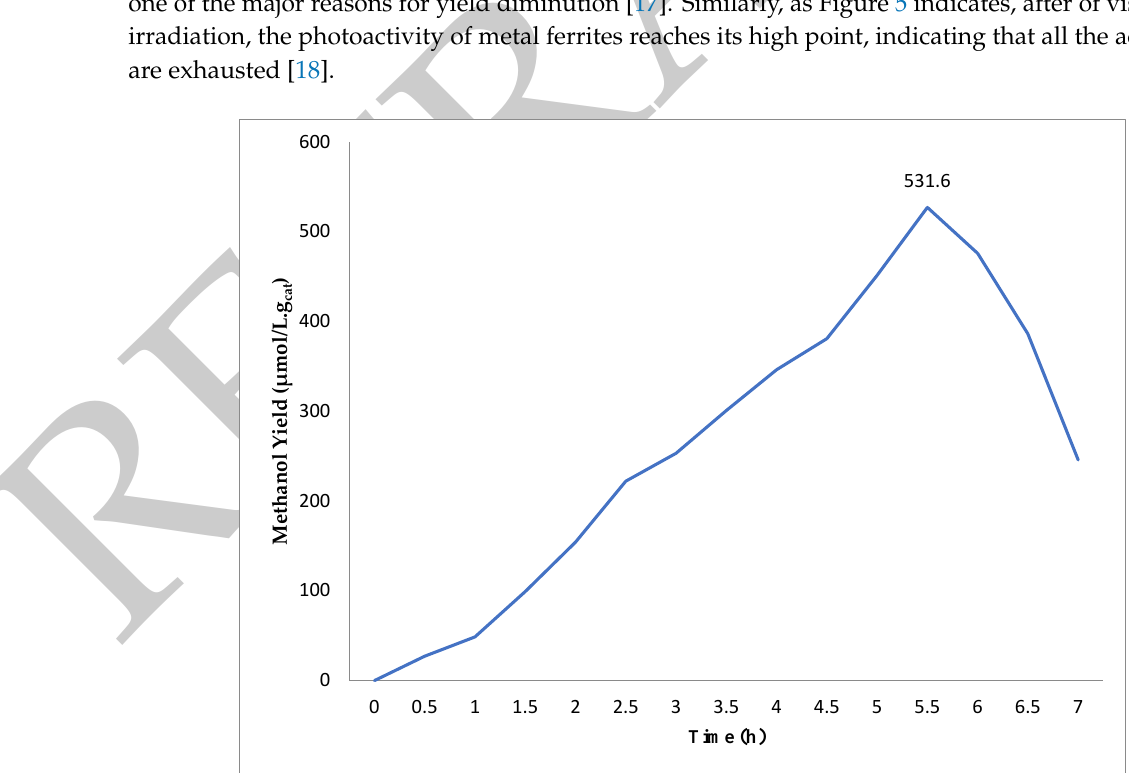
Figure 5. The activity of theZnFe 2 O 4 /TiO 2 (1:1 w/w) photocatalyst.